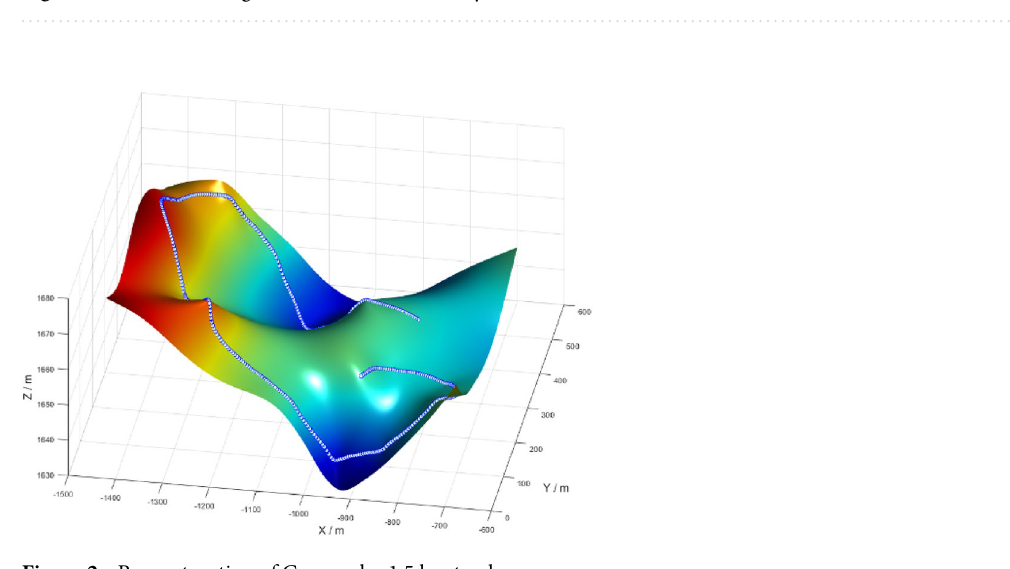
Figure 2. Reconstruction of Guyangshu 1.5 km